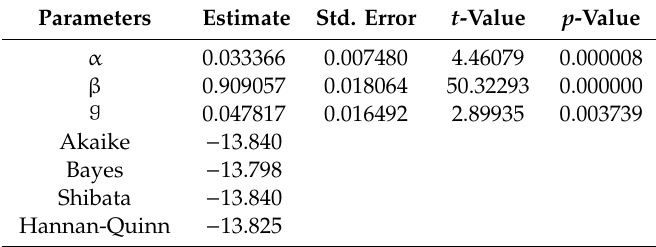
Table A2. Parameter Estimates of New Zealand’s Islamic-conventional ADCC-GARCH model. Table A3. Parameter Estimates of China’s Islamic-conventional ADCC-GARCH model. Table A1. Parameter Estimates of Hong Kong’s Islamic-conventional ADCC-GARCH model.